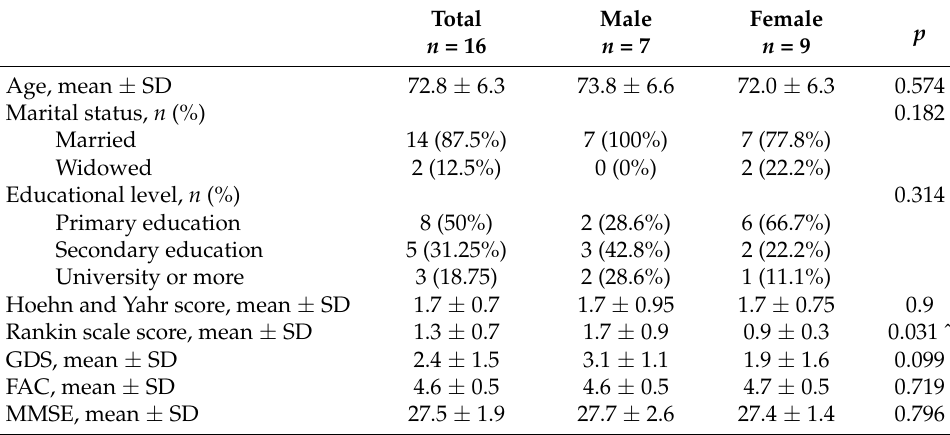
Table 2. Baseline demographic and clinical